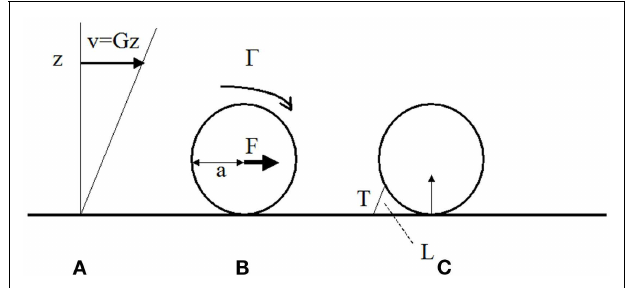
FIGURE 1 | Hydrodynamic forces on cells bound to blood vessel walls . (A) In a laminar viscous shear flow near a plane, the blood velocity at any point near the wall is parallel to the plane and equal to the distance z to the wall times the wall shear rate G (in s-1).The shear stress is the shear rate times the fluid viscosity µ ( µ ∼ 0.001Pa.s in aqueous medium). It represents the viscous force applied by the fluid on an unit area on the wall. (B) The fluid exerts on a sphere of radius bound to the wall a total force F ∼ 32 µ a 2 G and a torque G ∼ 11.9 µ a 3 G (Goldman et al., 1967). (C) if the sphere is maintained at rest by a single bond of length L and the contact between the surface and the wall is assumed to be frictionless, the tension T on the bond is ∼ 31 µ a 2 G (a/L) 1/2 (Pierres et al.,